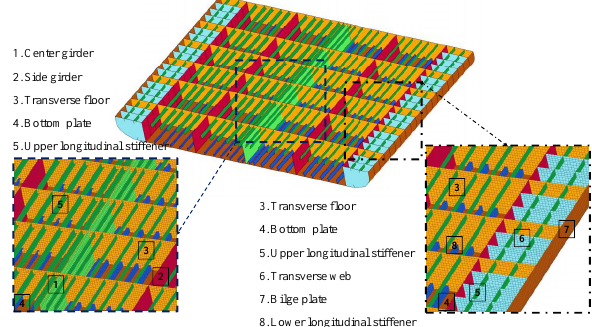
Figure 5. Geometry of the double bottom. Numbers highlight structural members on the model. Figure 5: Geometry of the double bottom. The numbers highlight structural members on the model